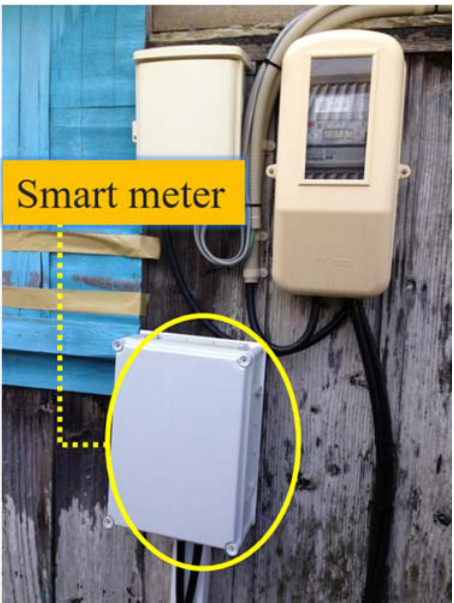
Figure 3. A smart meter installed in participant’s house. Source: Thoa et al. [4].